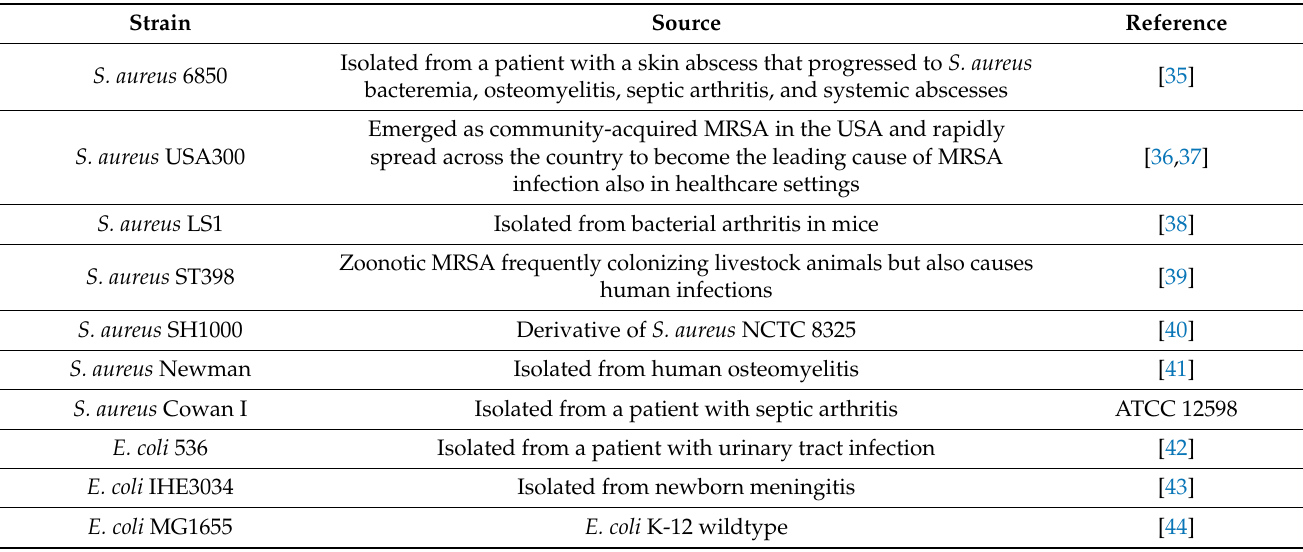
Table 1. Bacterial strains used in the present